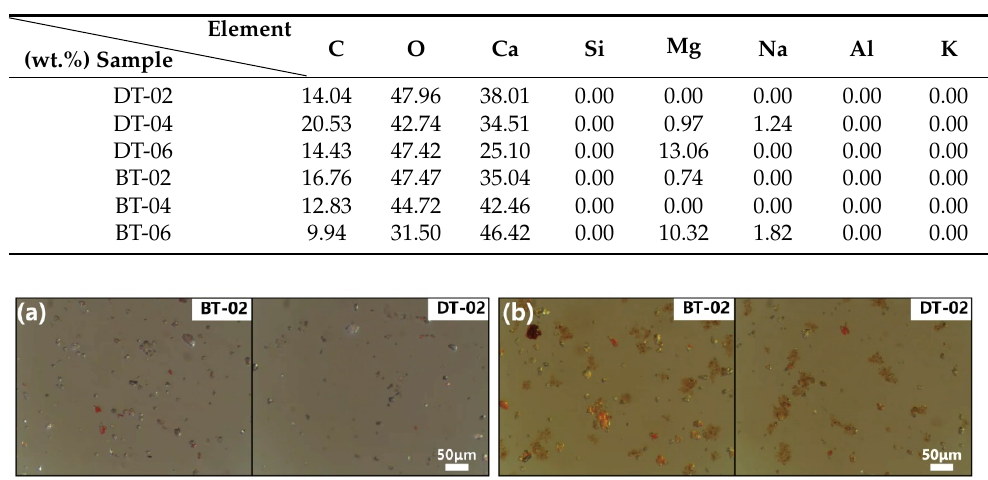
Figure 12. Micro-images obtained for the extracts of ground layer: ( a ) before iodine test; ( b ) after iodine test.